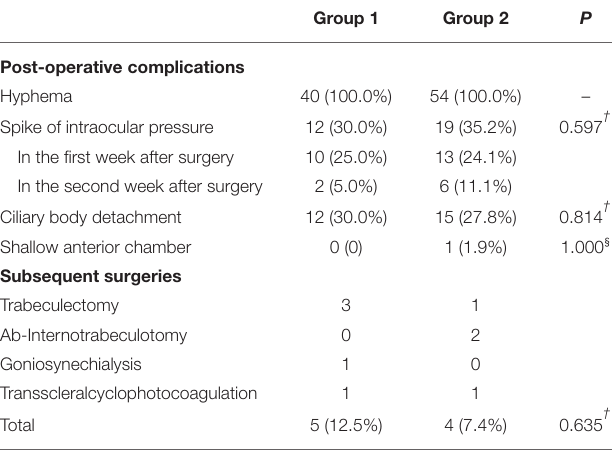
TABLE 3 | Post-operative complications and subsequent